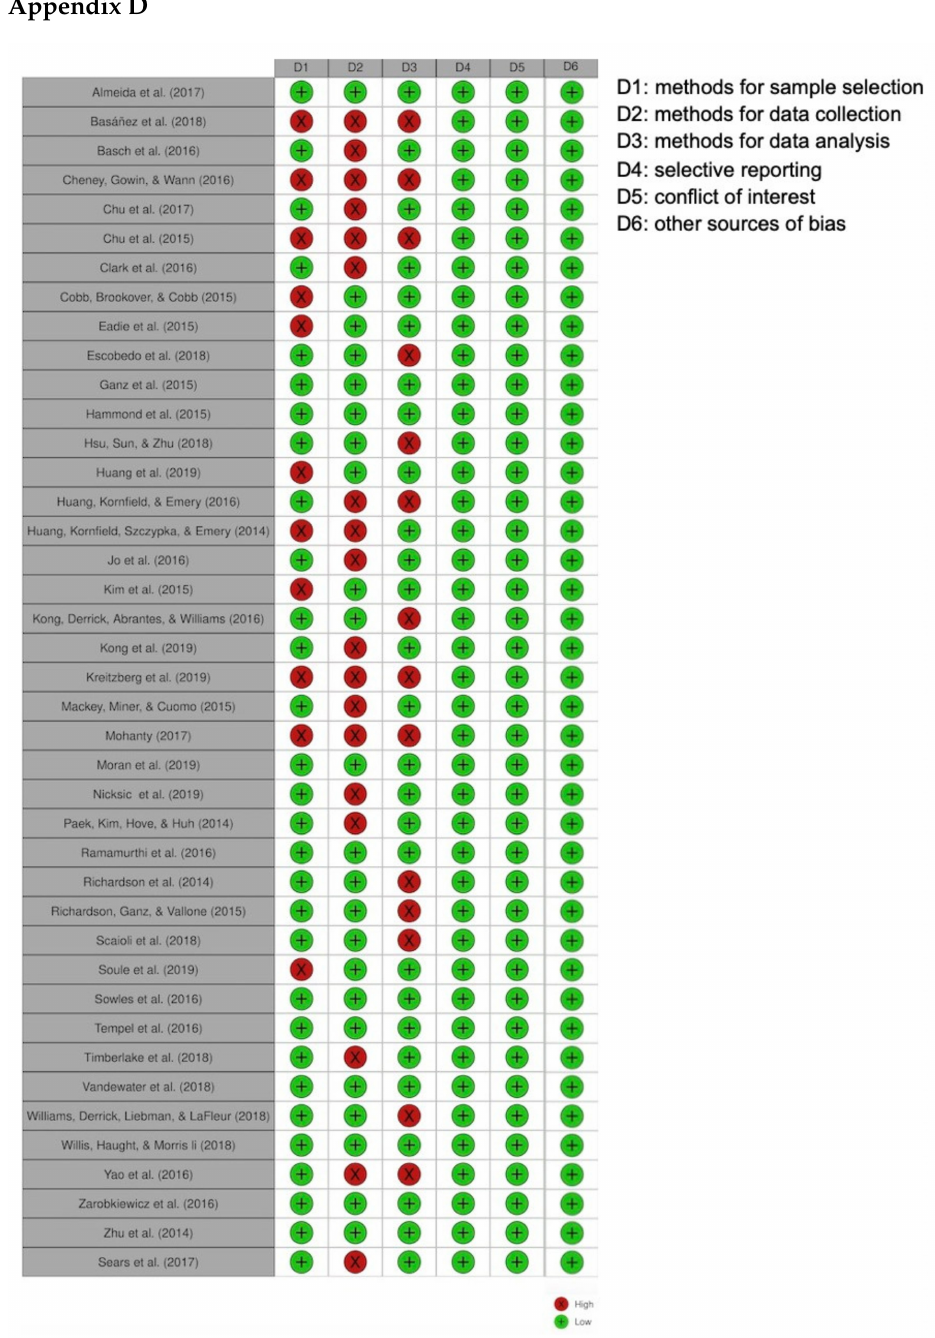
Figure A1. Risk of bias assessment of included studies ( n =